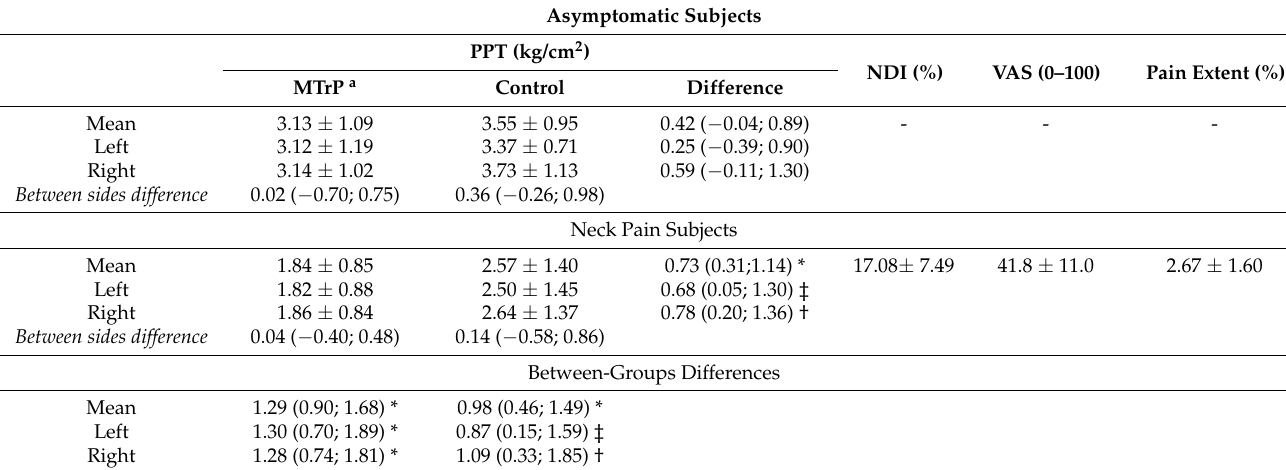
Table 2. Clinical characteristics of the